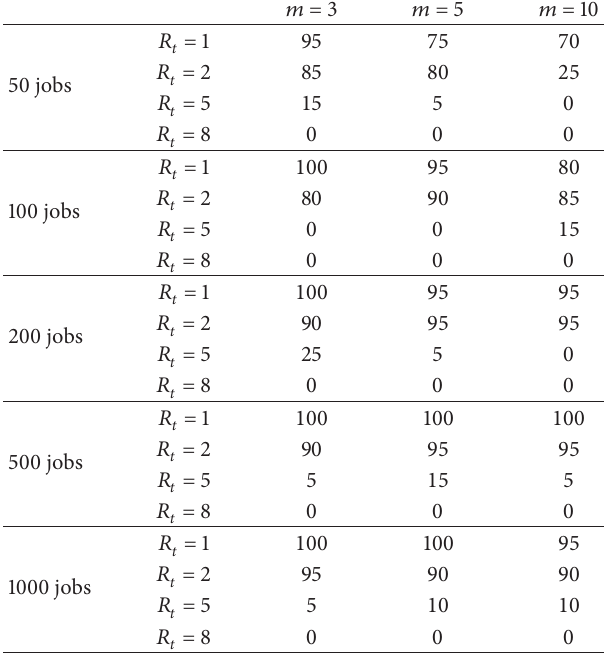
Table 5: Asymptotic performance tests for MGS (uniform distribu-